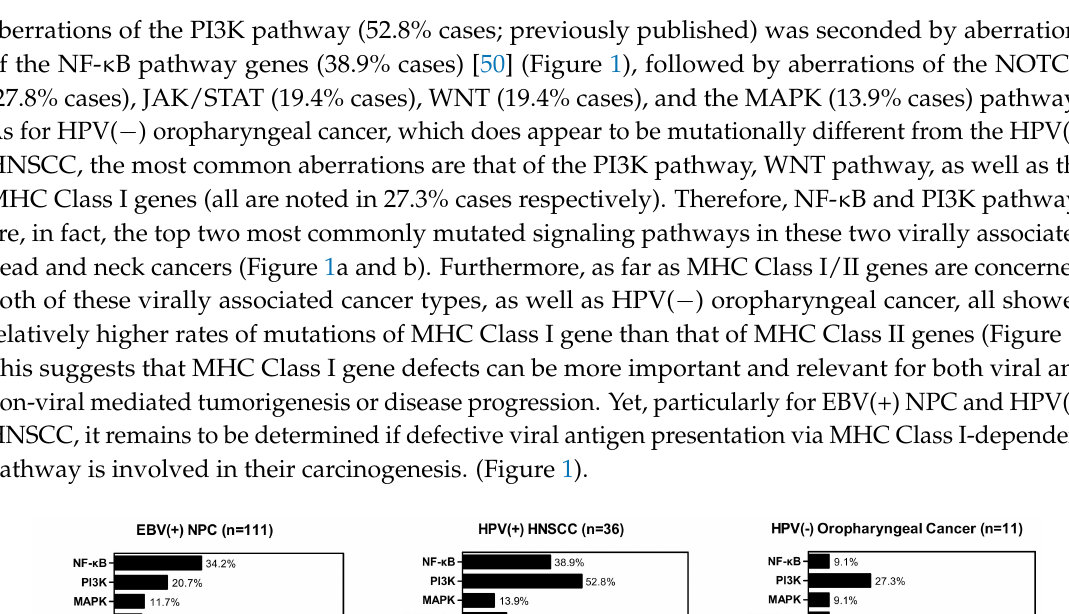
PIK3AP1 , PIK3IP1 , PDK1 , MTOR , TSC1 , TSC2 , PTEN , RICTOR , RPTOR , RHEB and PIK3R1/2/3/4/5/6 . The JAK/STAT pathway is defined as JAK1/2/3 , STAT1/2/3/4/5A/5B/6 , PTPN11 , IL6 , IL6R , IL6ST and SOCS3 . The MAPK pathway is defined as SHC1/2/3 , GRB2 , H/N/KRAS , A/BRAF , RAF1 , MAP2K1/2